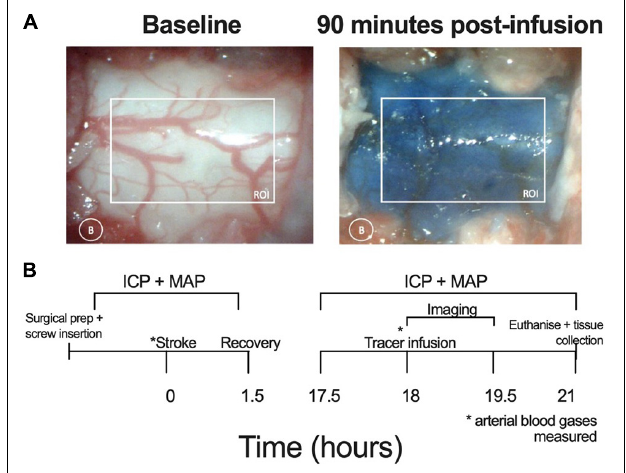
FIGURE 1 | (A) Representative images showing the respective absence and presence of Evans blue dye at baseline and 90 min post-infusion at the C7-T1 region in a stroke animal without ICP rise. The white box represents the region of interest (ROI) for quantifying contrast and the white circle indicates lateral measurement of background (B) changes. (B) Experimental timeline. Lateral ventricle screw insertion and physiological variable recordings were carried out prior to stroke. Evans blue dye was infused 18 h post-stroke and imaging was carried out 0–90 min post-infusion. Post-stroke physiological variables were recorded from 17.5 to 21 h post-stroke. Deep cervical lymph nodes were extracted following euthanasia. ICP, intracranial pressure; MAP, mean arterial pressure, * time point at which arterial blood gases (ABG)